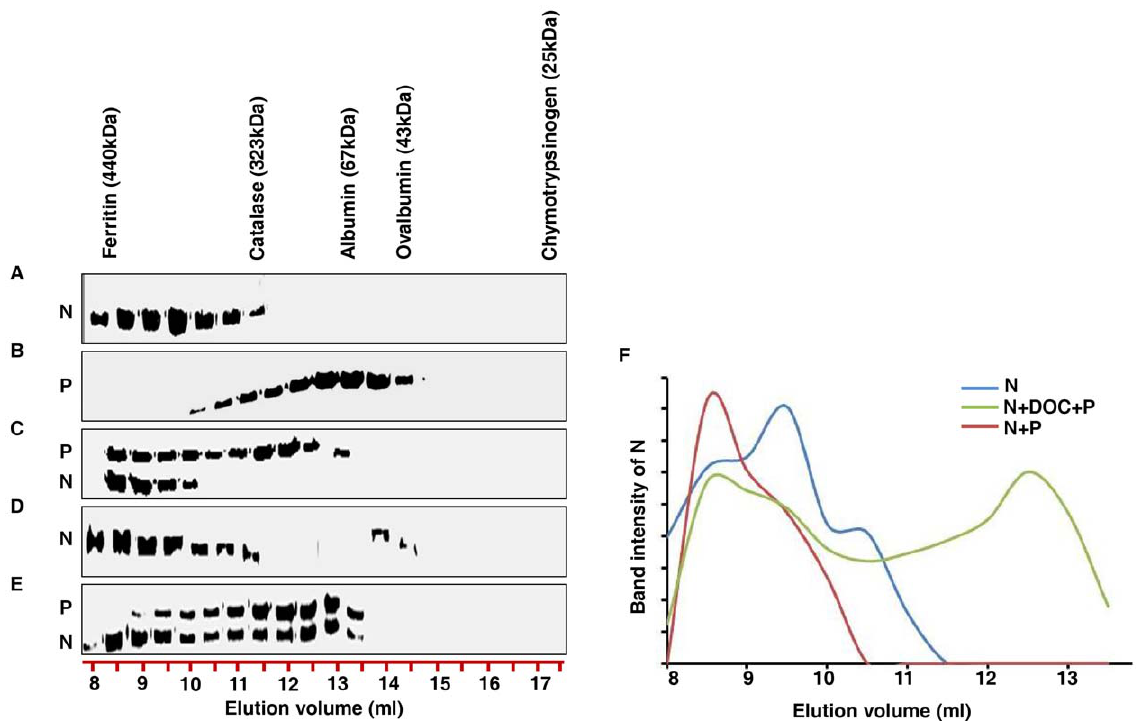
Figure 3. N forms distinct complexes with P invitro . Size exclusion chromatography of bacterially expressed purified N and P proteins, visualised by Coomasie brilliant blue staining. (A) N alone shows higher oligomeric distribution, suggesting decameric species. (B) P alone shows characteristic dimeric forms. (C) N and P incubated together at 4 u C for 30 minutes. Interaction between N (oligomer) and P is evident, as they co-elute just after the void volume fraction. (D) N treated with 1% DOC for 30 minutes and subsequently dialysed to remove DOC. Though DOC treatment dissociated the oligomeric N into monomeric forms, removal of DOC by dialysis allows them to re-oligomerize. (E) Similar to D, except for the fact that DOC was removed in the presence of equimolar concentration of P protein. Presence of P protein during DOC removal retains the monomeric population of N, and subsequently, monomer N-P complexes elute at around 12 ml. Elution profiles of gel filtration standard are shown for molecular weight estimation. (F) Plot representing densitometric scans of N bands with respect to elution volume in